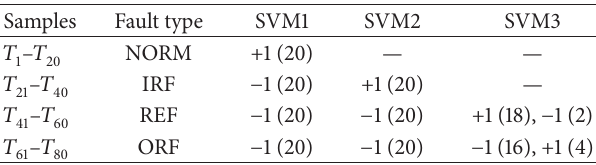
Table 2: The outputs of SVM-classifier with feature vector consist- ing of one